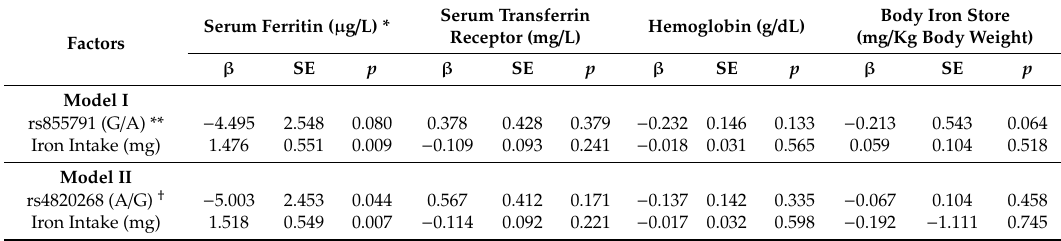
Table 3. Association between selected SNPs of TMPRSS6 with Serum Ferritin (SF), Soluble Transferrin Receptor (sTfR), Hemoglobin (Hb) and body iron store. Body Iron Store Serum Transferrin Hemoglobin (g / dL) Serum Ferritin ( µ g / L) * Receptor (mg / L) (mg / Kg Body Weight) Factors β SE p β SE p β SE p β SE p Model I rs855791 (G / A)